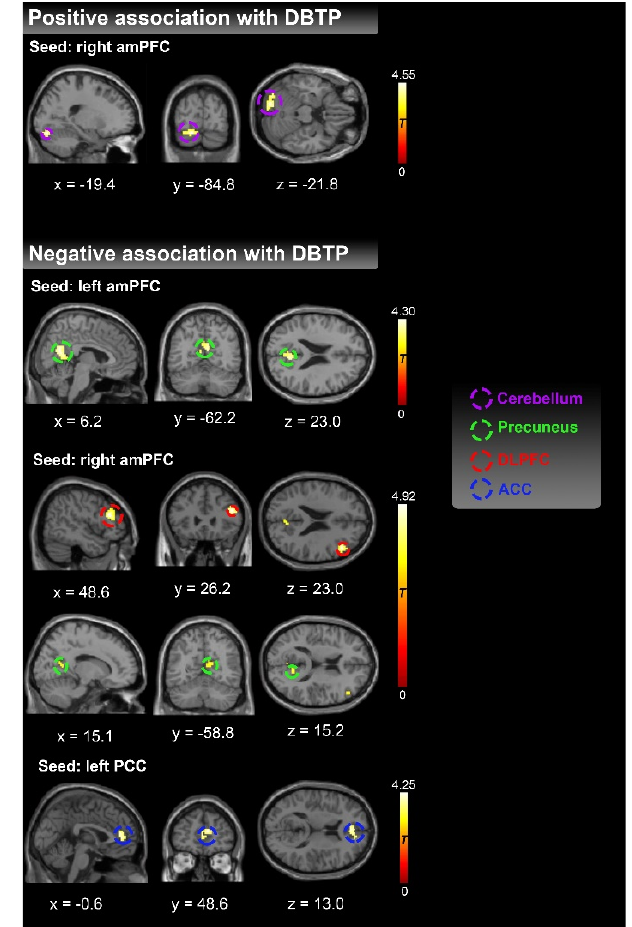
Figure 2. Resting state functional connectivity involving DMN core seeds (PCC, amPFC in both hemispheres) showing significant correlations with DBTP. DMN = default mode network, amPFC = anterior medial prefrontal cortex, PCC = posterior cingulate cortex, DLPFC = dorsal lateral prefrontal cortex, ACC = anterior cingulate cortex. DBTP = Deviation from Balanced Time Perspective.